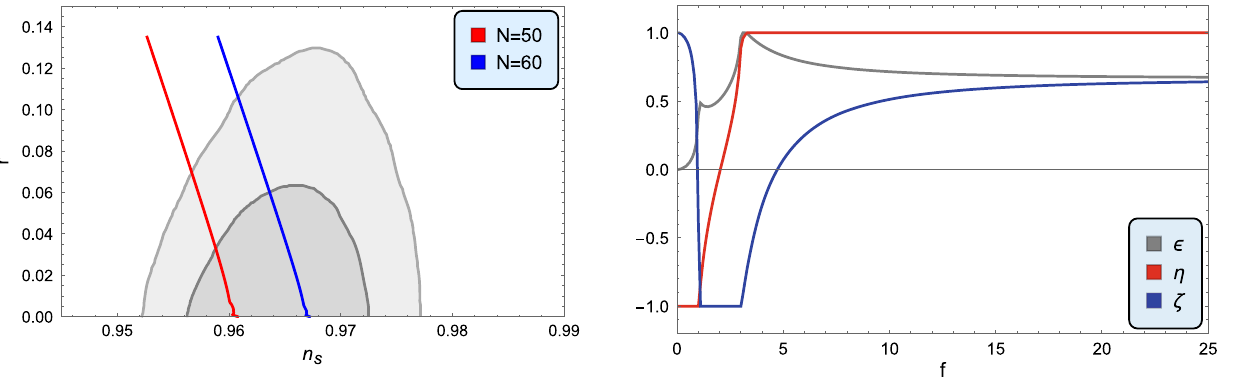
Fig. 3 The slow-roll parameters (cid:9) , η , and ξ versus f , which is in units of M Pl